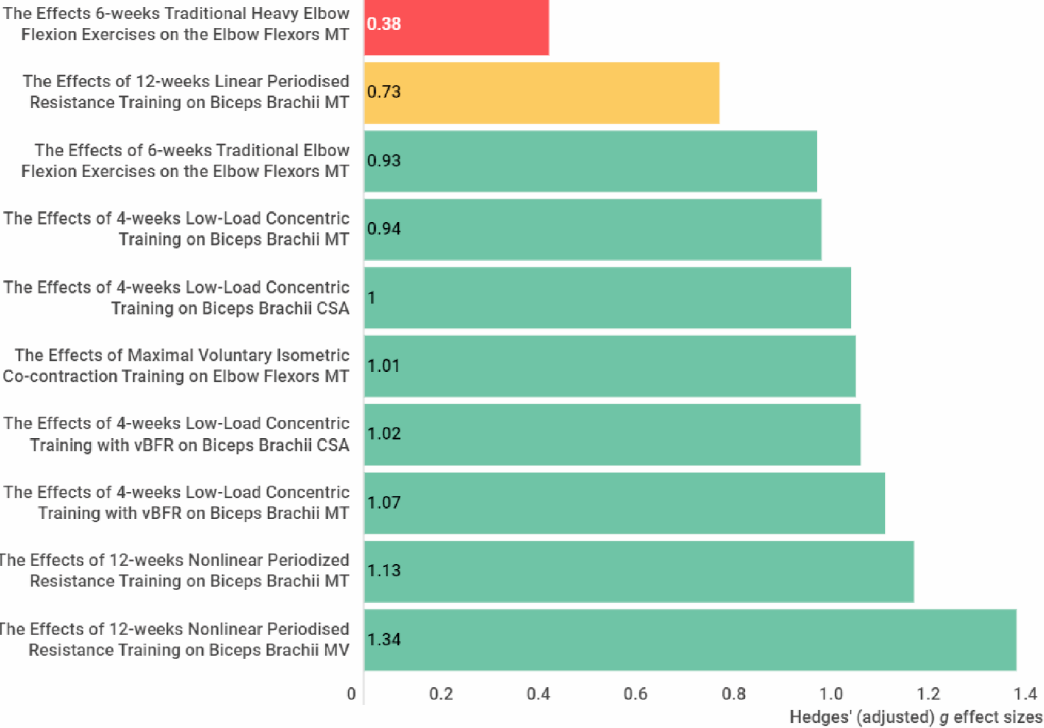
Figure 27. The effect size of the exercise interventions on the elbow flexors muscle thickness, muscle cross-sectional area and muscle volume. The red colour indicates a small or trivial effect size, the yellow colour indicates a medium effect size, and the green colour indicates a large effect size. Abbreviations: CSA, cross-sectional area; MT, muscle thickness; MV, muscle volume.